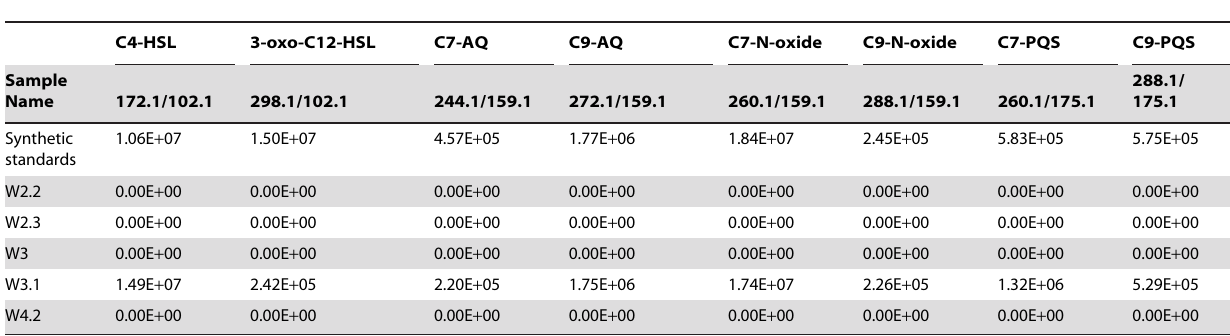
Table 1. Mass spectrometry identification of different quorum sensing signaling molecules from bacterial isolates spent